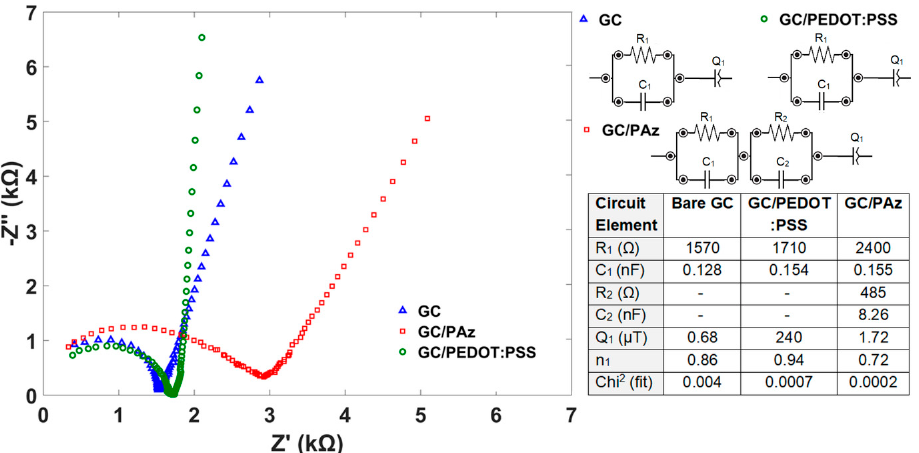
Figure 3. Nyquist plots for bare glassy carbon (GC), GC covered with PEDOT:PSS and PAz conducting polymers, and equivalent circuits (RCQ), and calculated values of the circuit elements (table). Based on the RCQ equivalent circuits, PAz shows the least capacitive behavior (the lowest n 1 —the exponent which defines character of the frequency dependence taking val- ues of 1 ≥ n ≥ 0), which may result in improved time stability of the sensor in respect to response and potential E 0 . The GC/PEDOT:PSS system exhibits the largest capacitive fea- tures, which may explain possible instabilities of the sensor’s response. The response time ( t 95 % ) of the sensors was defined as the time in which the potenti- ometric signal reaches 95% of the final value. Compared to the GC/PEDOT:PSS/ISM I elec- trodes (t 95% equal to approx. 45 s), the GC/PAz/ISM I electrodes show c.a. 10-fold decrease of the response time. The signal stability was revealed by measuring the signal drift and determining drift coefficient. The drift coefficient was described as the signal change dur- ing 1 h of measurement for the concentration of 1 mM NH 4+ . Compared to the GC/PE- DOT:PSS electrodes, as expected, the PAz electrodes showed significantly lower signal drift coefficient. The lowest signal drift coefficient was obtained for GC/PAz/ISM III . As mentioned before, the surface of PEDOT:PSS modified electrode is hydrophilic in contrast to the surface of the PAz modified electrodes, which are hydrophobic. Due to the hydro- philic nature of PEDOT:PSS, during conditioning, a layer of water forms between the pol- ymer layer and the membrane, which has an influence on the stability of the electrode and increases the potentiometric response time. The hydrophobic nature of the PAz has a pos- itive effect on the stability of the ion-selective electrodes’ response. It stays in agreement with the previously discussed results for highly hydrophobic PEDOT derivative and PAz ion-to-electron transducer. 3.3. Urea Biosensor Based on PAz Electroactive Layer Ion-selective electrodes based on PVC or PVC-COOH membrane with fluorinated lipophilic salt (GC/PAz/ISM I and GC/PAz/ISM II ) were biofunctionalized with urease by two protocols based on GA crosslinking and EDC/NHS coupling, described in the exper- imental paragraph, respectively. Following the most efficient protocol employed for GC/PEDOT:PSS/ISM I /E, the PAz-based ISEs with PVC membrane were biofunctionalized by dropping 60 μ L of urea and BSA solution (12 and 10 mg/mL, respectively) and 30 μ L of 5% glutaraldehyde solution. In the case of ISEs with PVC-COOH membranes, biofunc- tionalization was performed by covalent binding of urease to the carboxylic groups pre- sent on the membrane surface using an EDC/NHS coupling agent. Three polymers with 1.8, 5 or 10% of carboxylic groups were tested. Metrological parameter analysis of ammo- nium ion sensors based on PVC and PVC-COOH has shown that carboxylation may have a beneficial effect on the response time of the sensor. However, the urea sensors with car-